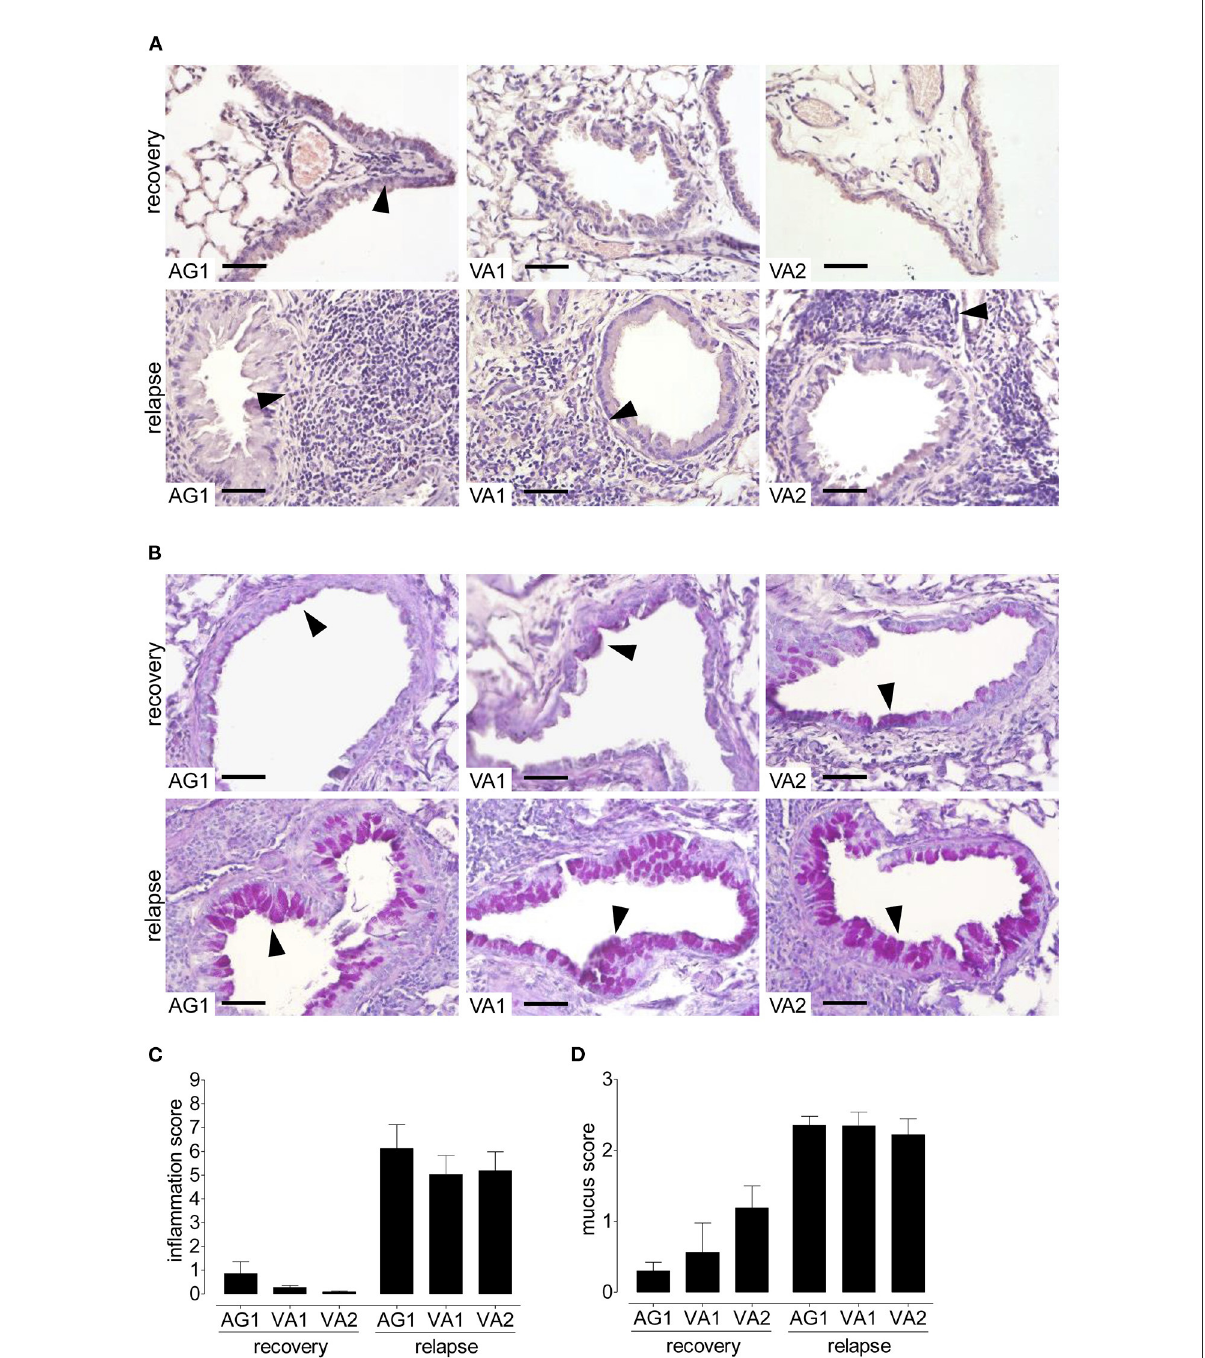
FIGURE7 Lung inflammation and mucus secretion during disease relapse elicited by AG1, VA1, and VA2 pollen. Representative photomicrographs of H & E- and PAS- stained lung tissue sections from AG1, VA1, and VA2 pollen (10 µ g per 50 µ l PBS) at a magnification of 400 × . (A) In H & E-sections, recovered mice have infiltrates without eosinophils, in contrast to relapse with inflammation containing eosinophils (arrows). (B) In PAS-stained lung tissue sections, recovered mice have some mucus in goblet cells (arrows) compared with an increase in the rechallenged mice. Graphs illustrate the quantification of the lung sections using a blinded semi-quantitative scoring system for lung inflammation (C) and mucus production (D) . Scale bars are 50 µ m. Data are presented as mean ± SEM and are representative of at least two experiments; n =